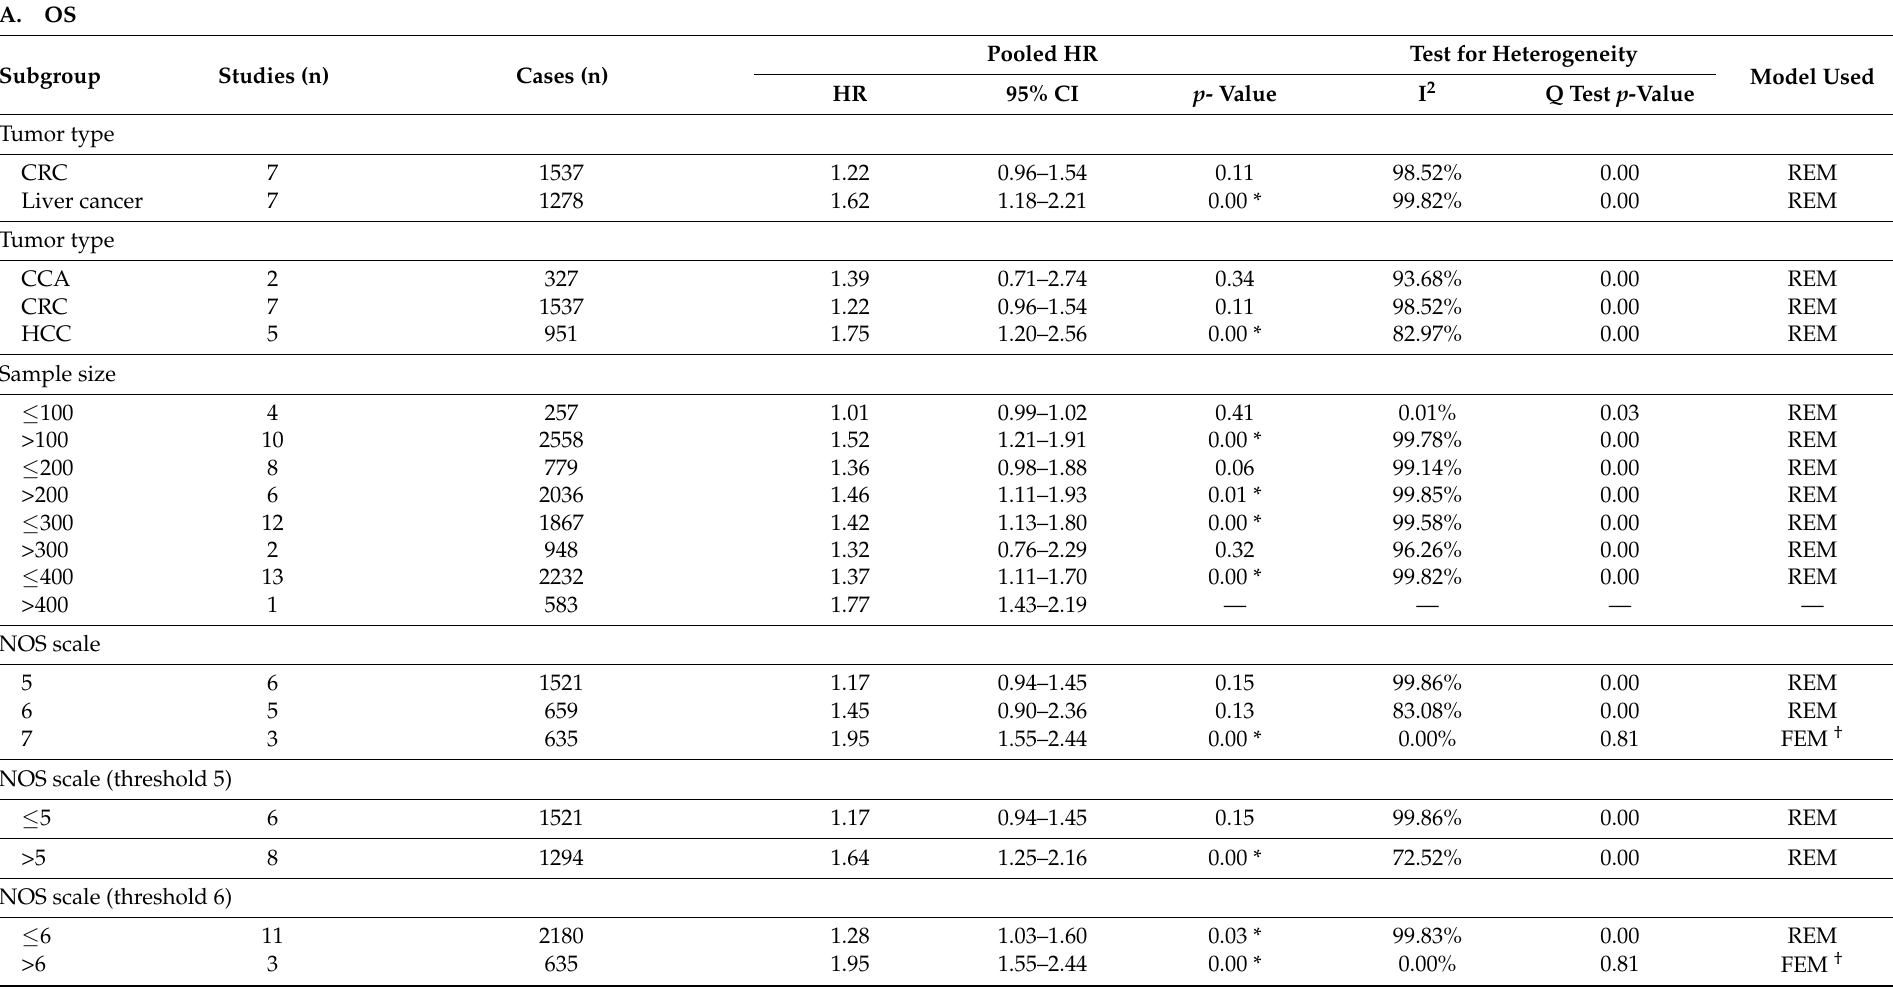
Table 3. Subgroup analysis of prognostic and tumor pathogenesis correlation with NRP1